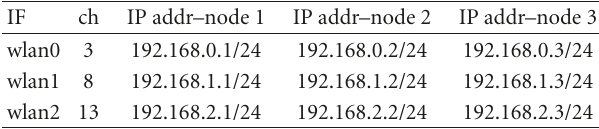
Table 1: An example of wireless channel and IP address